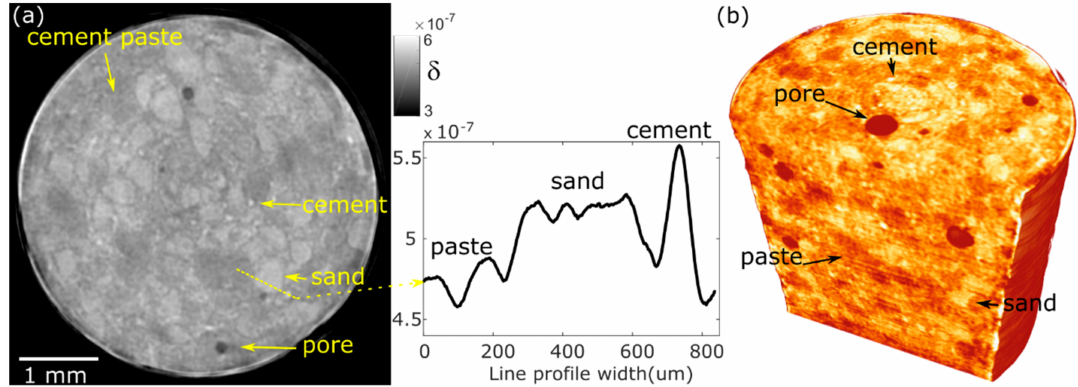
Figure 3. ( a ) Reconstructed tomographic slice of phase image of a mortar specimen. Inset shows the intensity profile of the dashed line marked in the slice. ( b ) Volume rendering from the reconstructed